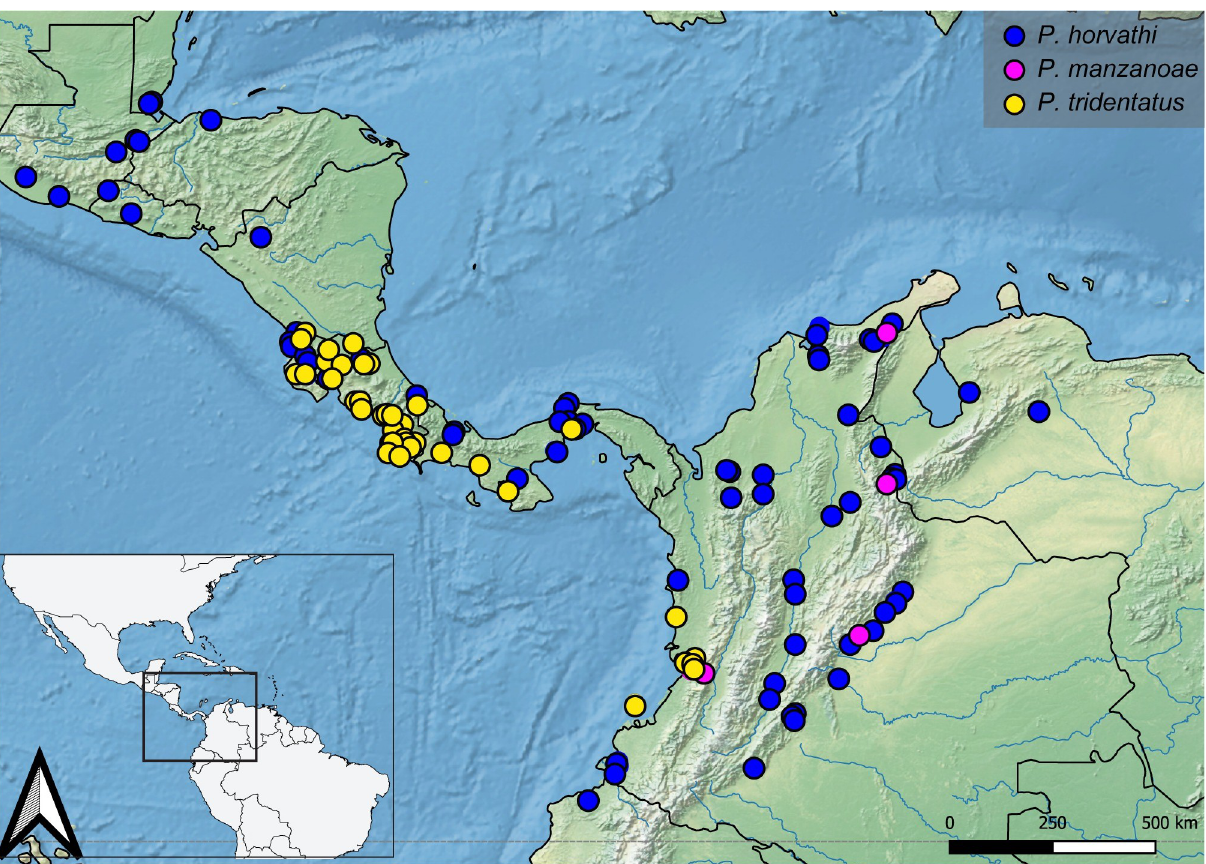
Fig 38. Map showing the geographical distribution of species of P . horvathi , P . manzanoae , P . tridentatus . Spatial data from Natural Earth (http:// www.naturalearthdata.com/).